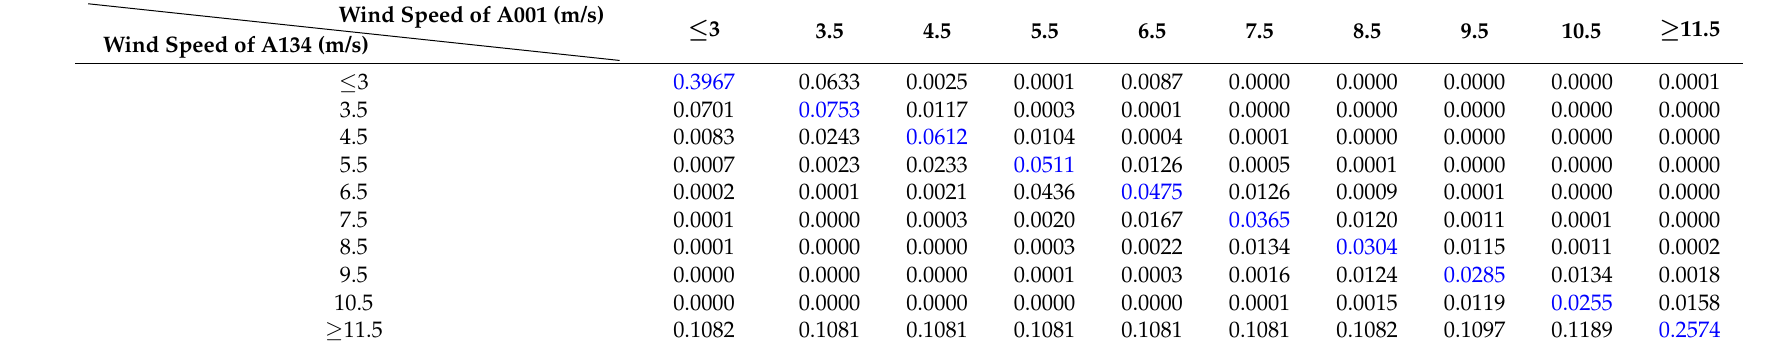
Table 3. Joint probability of discrete wind speeds of wind turbines A001 and A134.